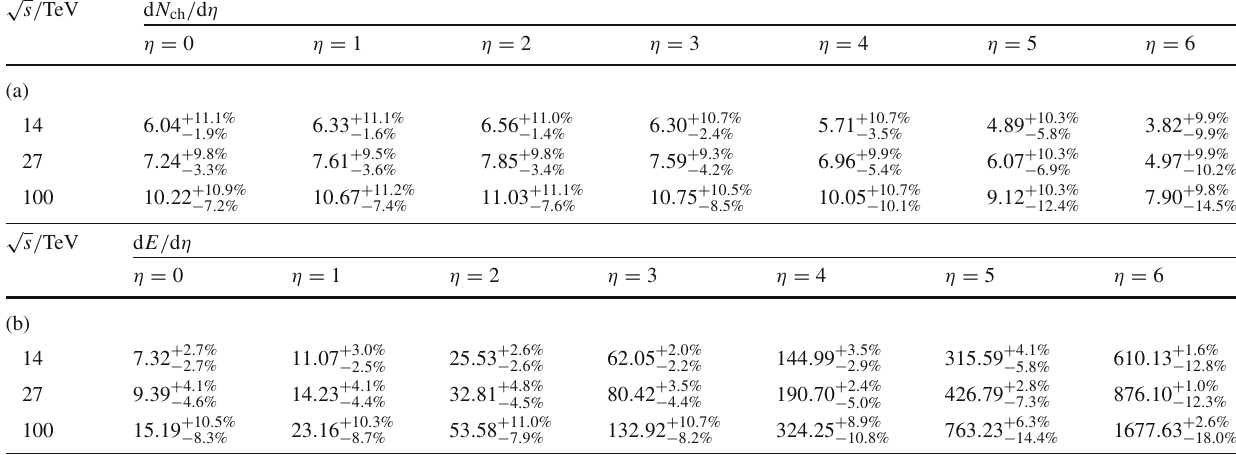
Table 9 Tables showing (a) the number density of charged tracks with particles with proper lifetimes c τ 0 < 10 mm are considered to decay. c τ 0 ≥ 10 mm, and (b) the energy density of all final-state particles Uncertainties are shown as percentages and are found as described in the excluding neutrinos and muons, for different η slices as predicted by √ s = 14,27,100TeV. Only the Monash 2013 tune of Pythia 8.2, at